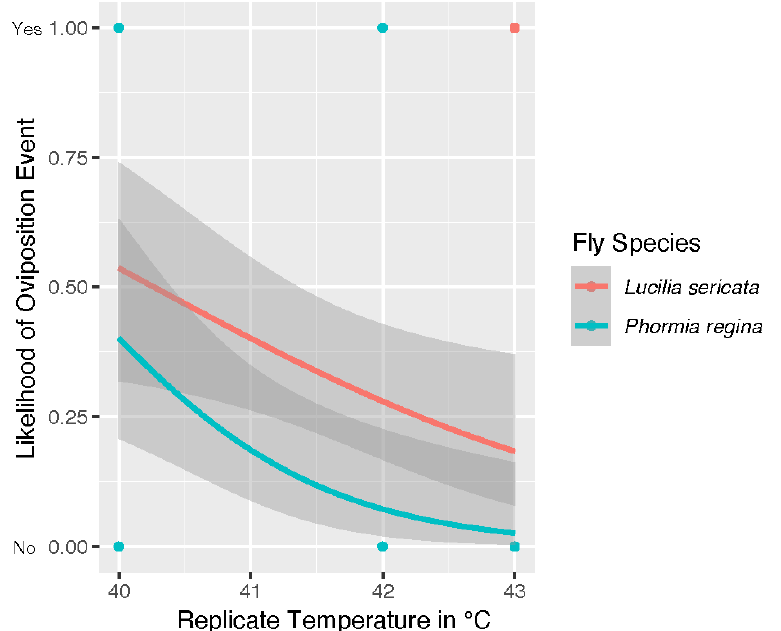
Figure 3. Model projected likelihood of oviposition event for Lucilia sericata (light red) and Phormia regina (teal) as temperatures increased measured from data collected at 40 °C, 42 °C, and 43 °C for both species. Outcomes were measured as yes (eggs) or no (no eggs). These data indicates Lucilia sericata is statistically more likely ( p = 0.034) to lay eggs at temperatures over 40 °C. Temperature was also a significant factor with a p = 3.01 × 10 − 4 .